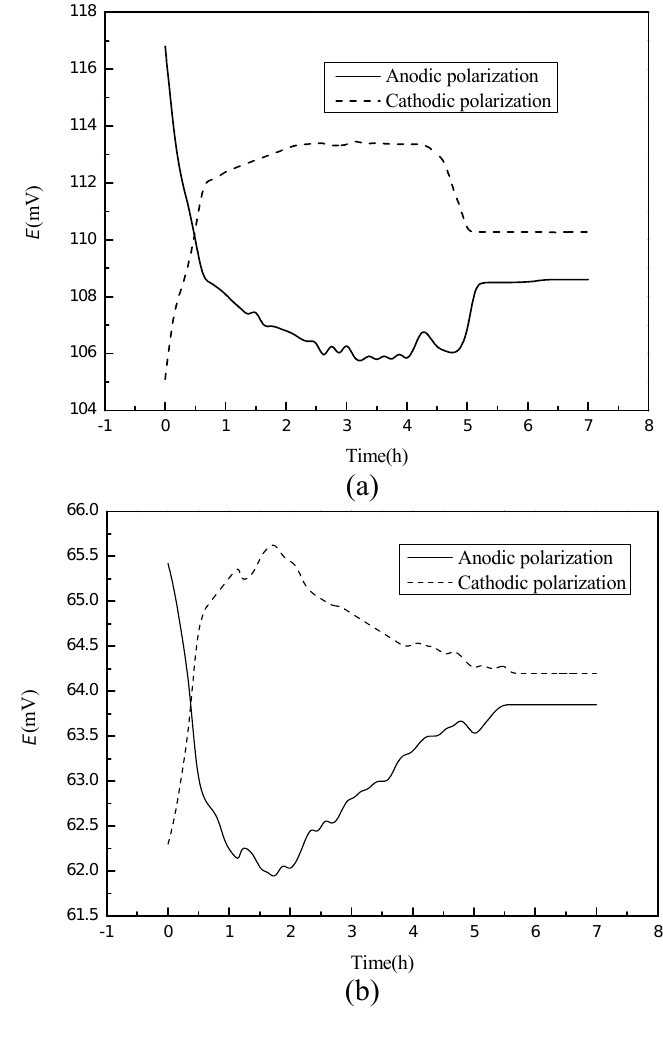
Figure 5. (a) Galvanostatic polarization curve of the sensor in synthetic concrete pore solutions with 0.1 mol/L NaCl. (b) Galvanostatic polarization curve of the sensor in synthetic concrete pore solutions with 1.0 mol/L